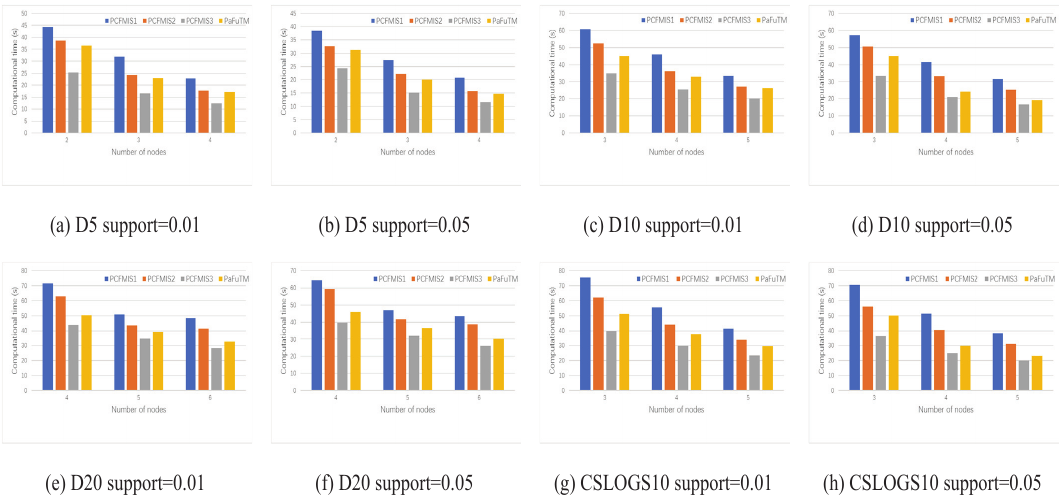
Figure 5. Computational time of four algorithms for four data sets on a small number of